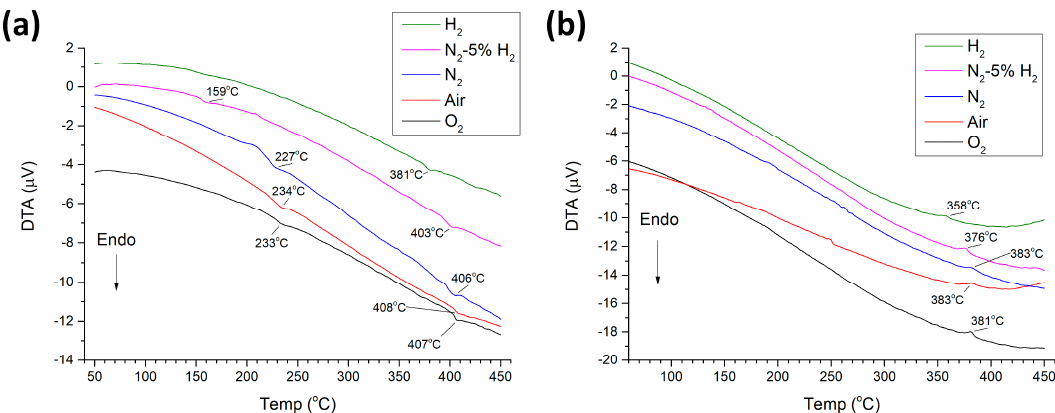
Figure 10. ( a ) Ascending and ( b ) descending DTA traces of KNbO 3 samples sintered at 1040 °C for 3 h in different atmospheres. Table 2. DTA phase transition temperatures of KNbO 3 samples sintered at 1040 °C for 3 h in different atmospheres.